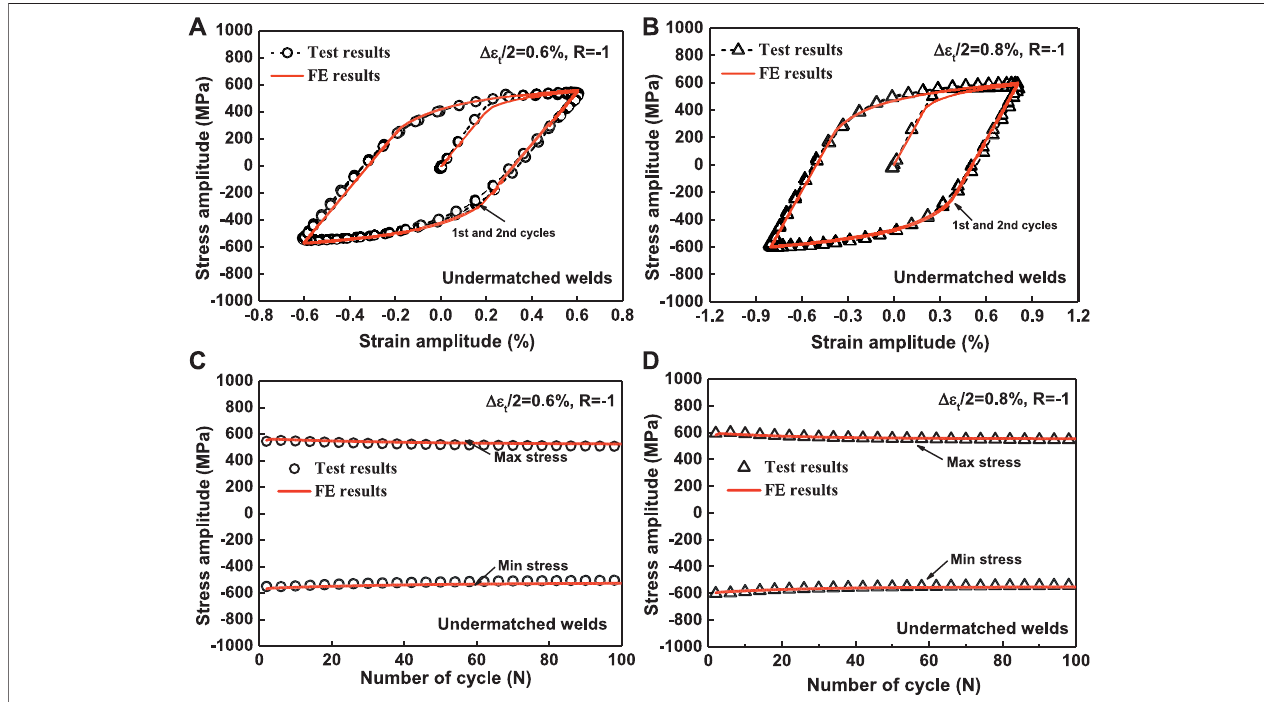
FIGURE 7 | Experimental and simulation comparisons of the fi rst and second cyclic hysteresis loops and max – min stress evolution for undermatched welds. (A) Hysteresisloopsunder Δ ε t /2 (cid:1) 0.6%, (B) hysteresisloopsunder Δ ε t /2 (cid:1) 0.8%, (C) max – minstressevolutionunder Δ ε t /2 (cid:1) 0.6%,and (D) max – minstressevolutionunder Δ ε (cid:1) 0.8%. t /2